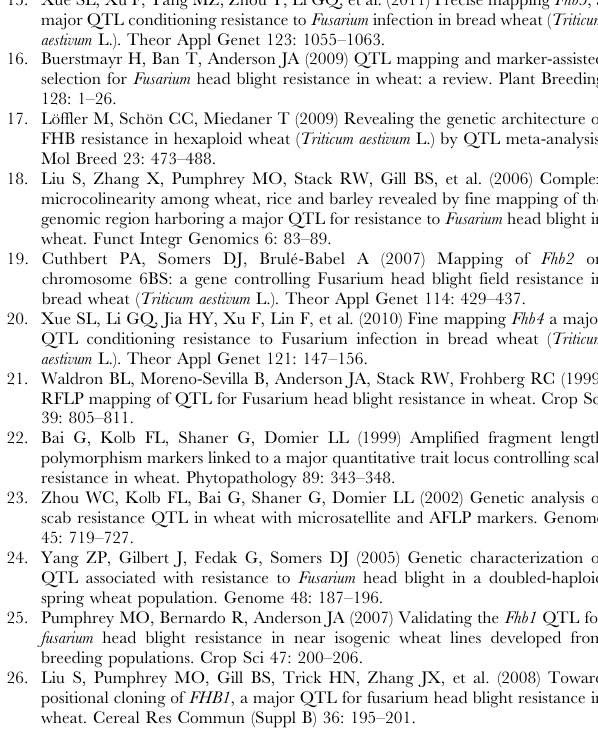
Table S3 FHB-related traits of wheat accessions clustered into the same subgroup as Sumai 3 by UPGMA based on a Manhattan dissimilarity matrix. Table S4 Comparison of FHB-related traits between the two alleles at umn10 in both European and Asian wheat gene pools. Table S5 Passport data of 266 wheat accessions with detailed pedigree information and four controls included in the study. Table S6 FHB resistance evaluation data in three environments and theirs mean value. Table S7 The sequences of molecular markers and theirs physical positions on ctg954 BACs contig. Table S8 Genotyping data of all accessions for 43 3B-specific markers and 70 whole-genome SSR